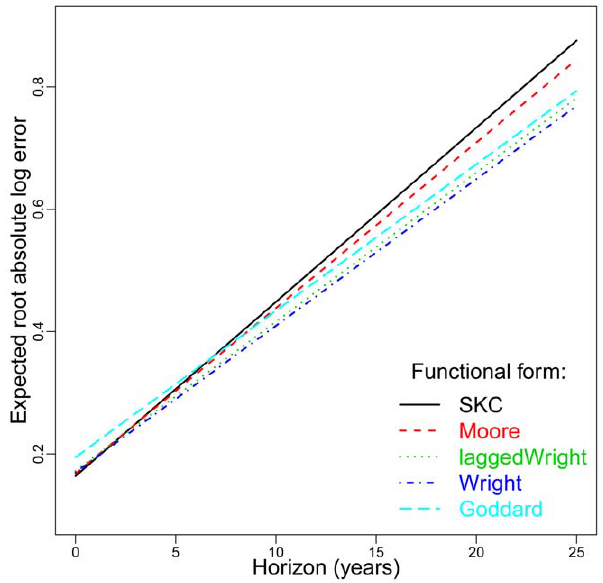
Figure 2. An illustration of the growth of errors of each hypothesized law vs. time. The plot shows the predicted root absolute log error r fij vs. forecasting horizon ( j { i ) using each of the functional forms (see Eq. (6)). The performance of the five hypotheses shown is fairly similar, though Goddard is worse at short horizons and SKC and Moore are worse at long